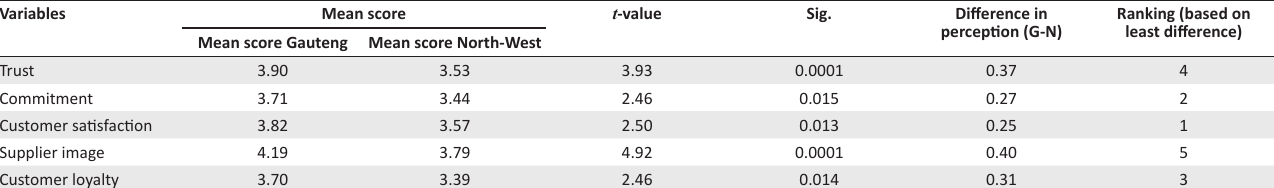
TABLE 5: Comparison between perceptions of Gauteng and North-West respondents. Variables Mean score